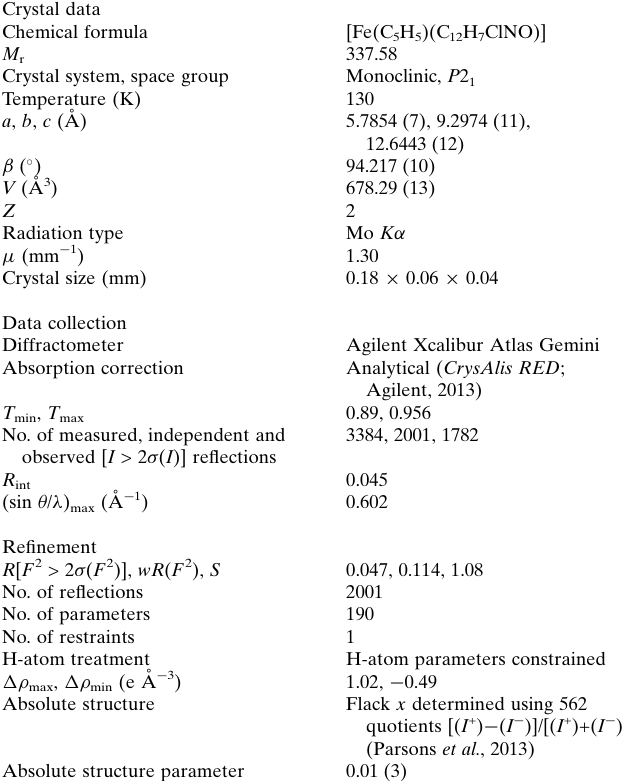
Table 1 Experimental details. Crystal data Chemical